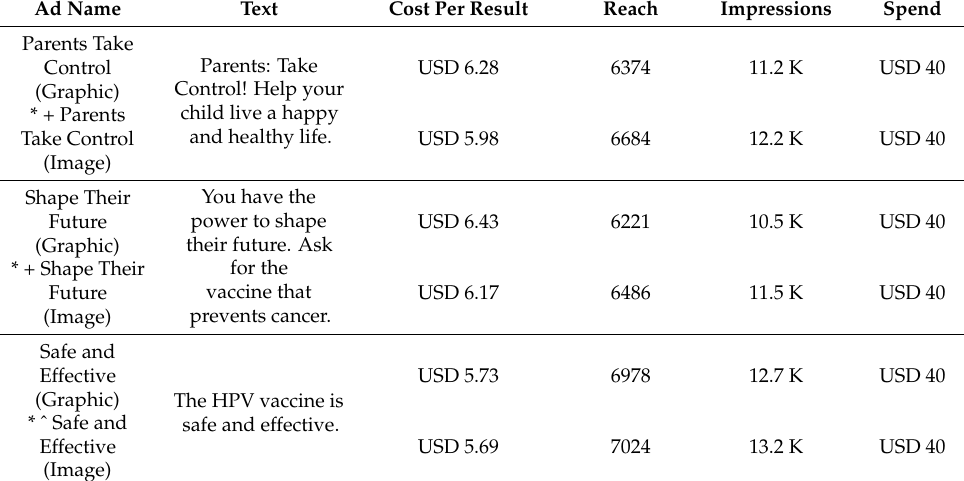
Table 3. Top performing ads based on split-testing.